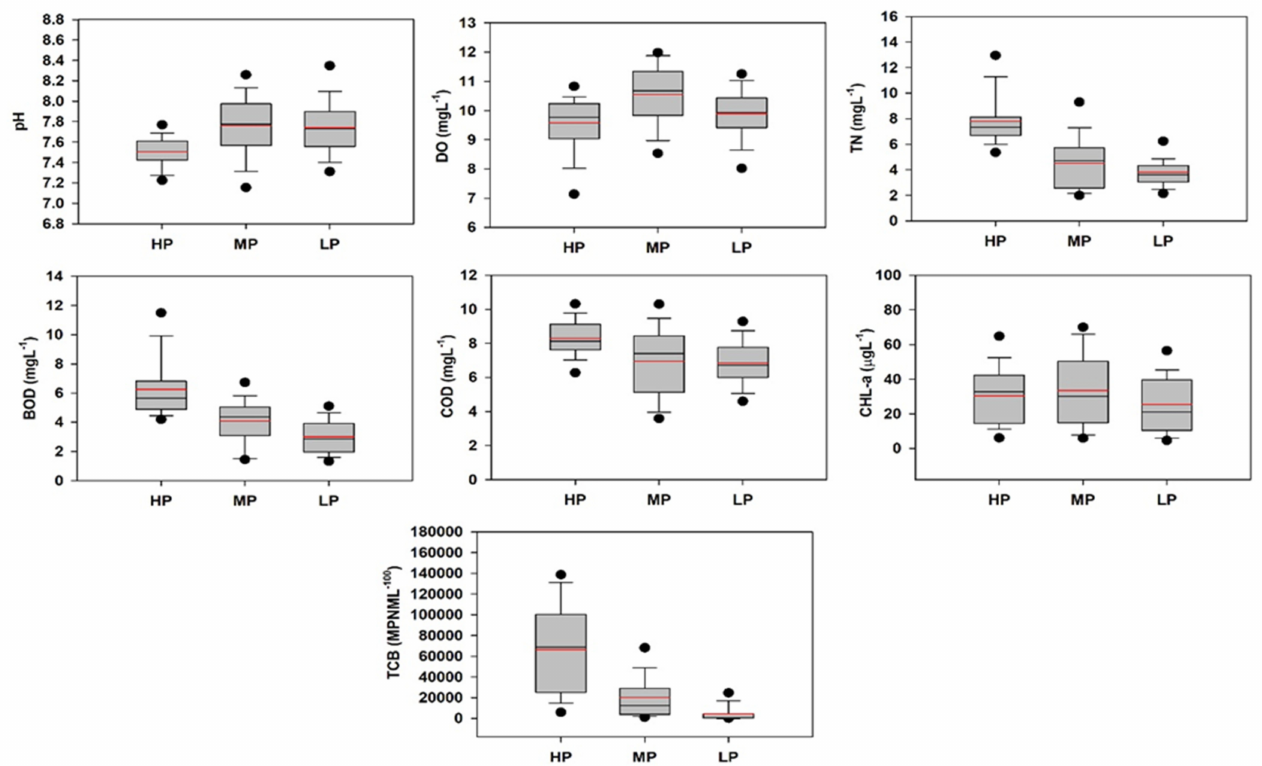
Figure 7. Spatial variations in pH, DO, TN, BOD, COD, CHL-a, and TCB in the Yeongsan River (pH: hydrogen ion concentration; DO: dissolved oxygen; TN: total nitrogen; COD: chemical oxygen demand; CHL-a: chlorophyll-a; TCB: total coliform bacteria; HP: highly polluted; MP: medium polluted; LP: less